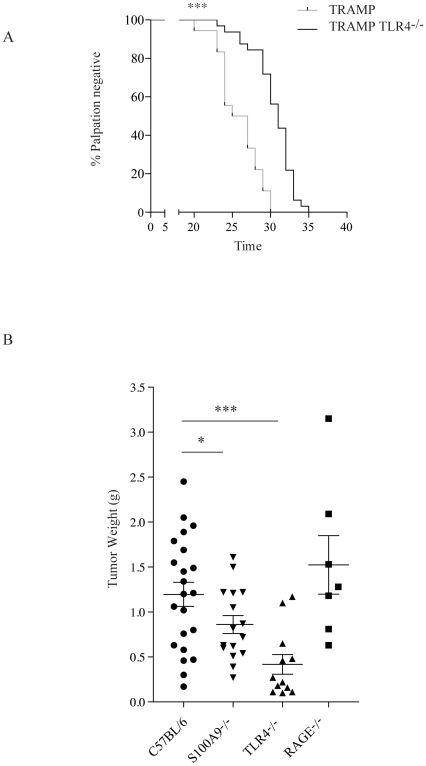
TRAMP tumor growth is delayed in TLR4−/− mice and EL4 lymphoma growth in both S100A9−/− and TLR4−/− animals.A. Time to palpable tumor curves for C57BL/6 TRAMP mice (black line; n = 18) and TRAMP TLR4−/− mice (dashed line; n = 32). The median time to palpable tumor (TM) was 26 and 31 weeks, respectively (p = <0.0001; Gehan-Breslow-Wilcoxon). B. Tumor weight of EL4 lymphoma tumors scored 14 days after subcutaneous inoculation in C57BL/6, S100A9−/−, RAGE−/− and TLR4−/− animals. Statistical analysis using two-tailed t test *** p = 0.0008; * p = 0.039.